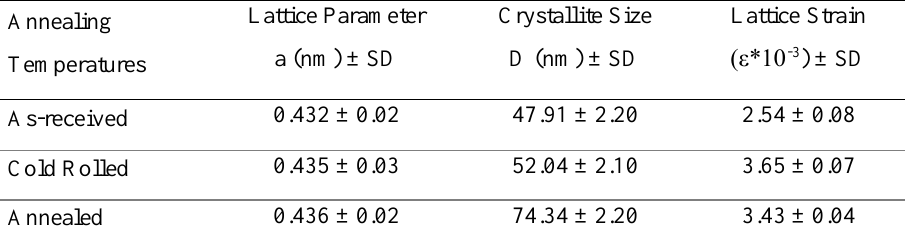
Table 2. Calculated values of lattice parameter, crystallite size, Lattice Strain with Standard Deviation (SD) of AA5083 before and after Heat treatment at different